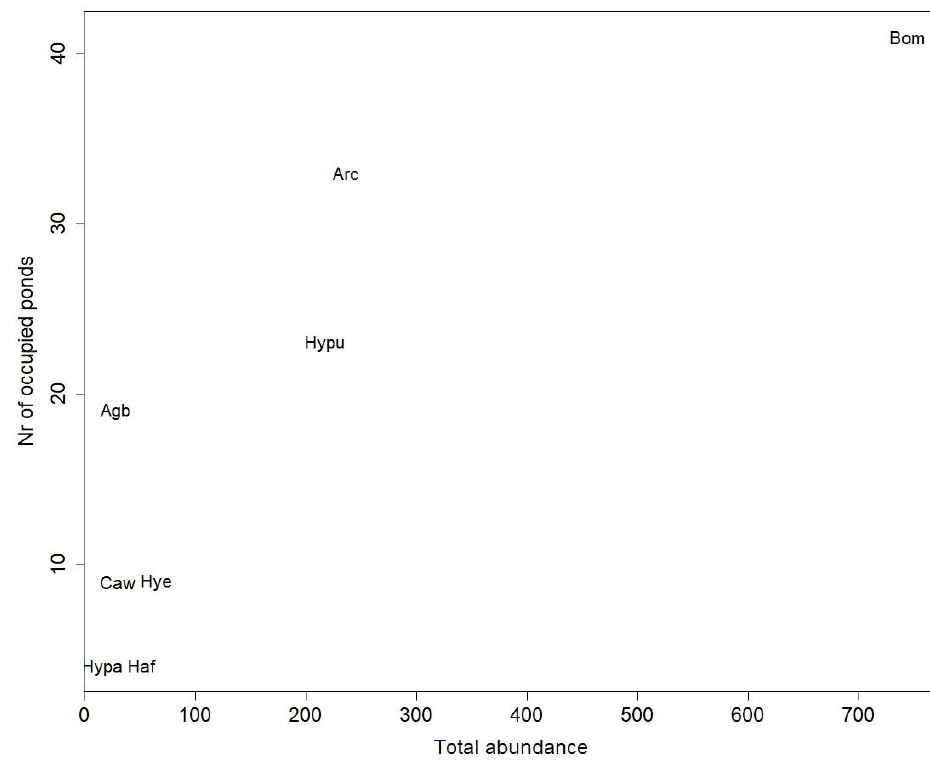
Figure 2. Frequency and abundance of water beetles and water boatmen in Faroese ponds. Species acronyms are as listed in Table 1. acronyms are as listed in Table 1.